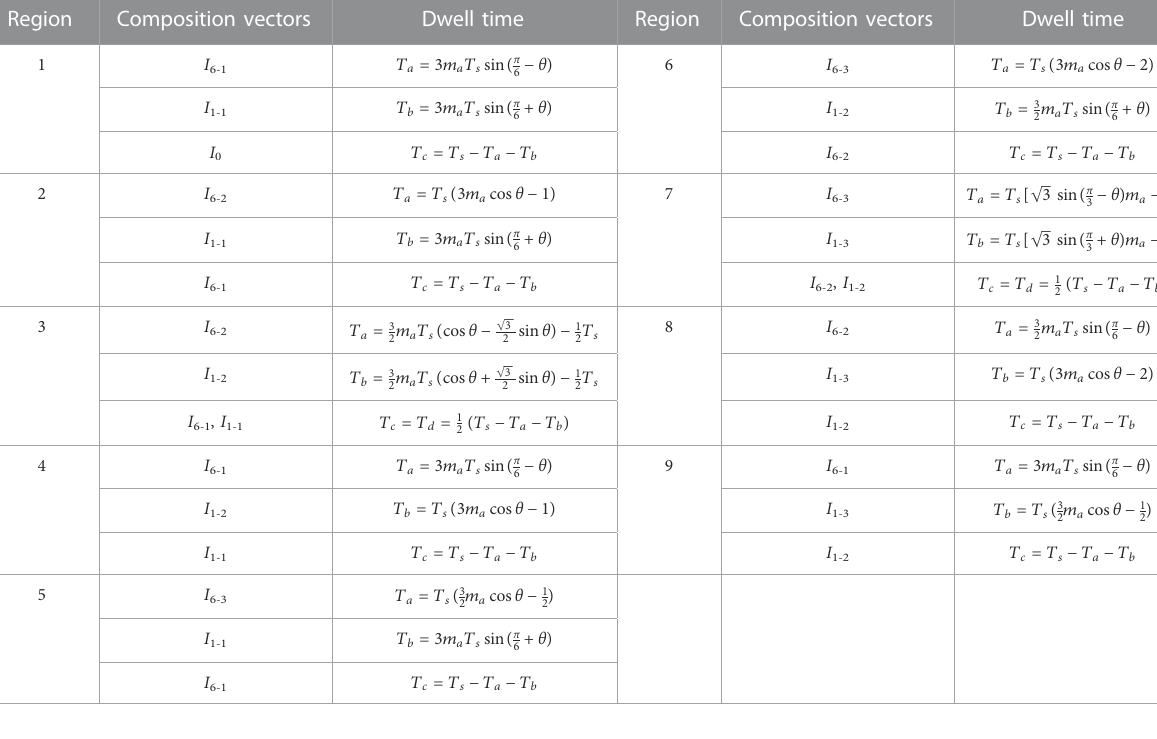
TABLE 2 Composition vectors of reference in sector I. Region